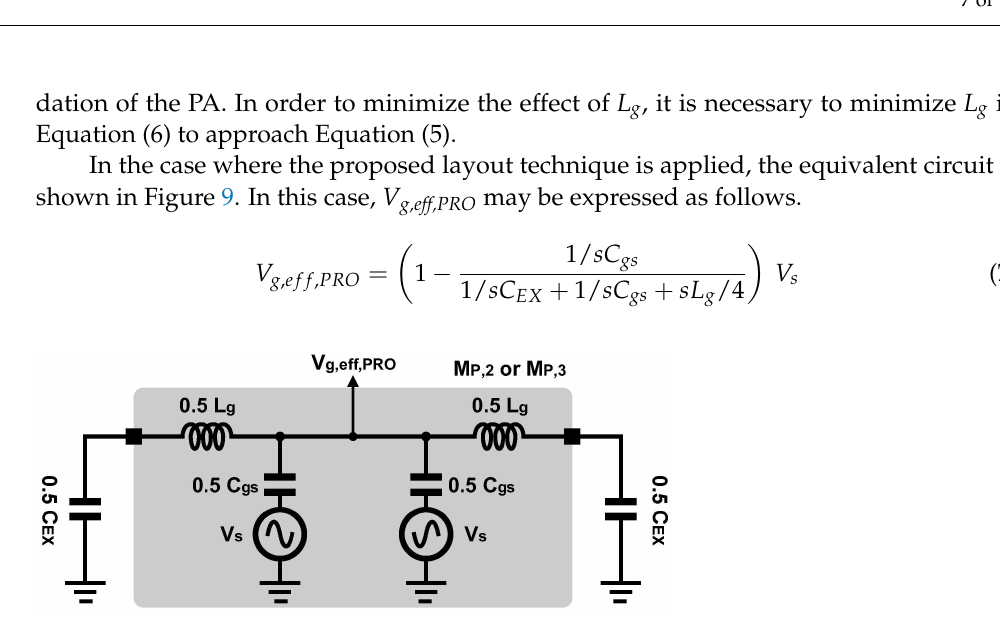
Figure 9. Equivalent circuits of power transistor with proposed layout technique.